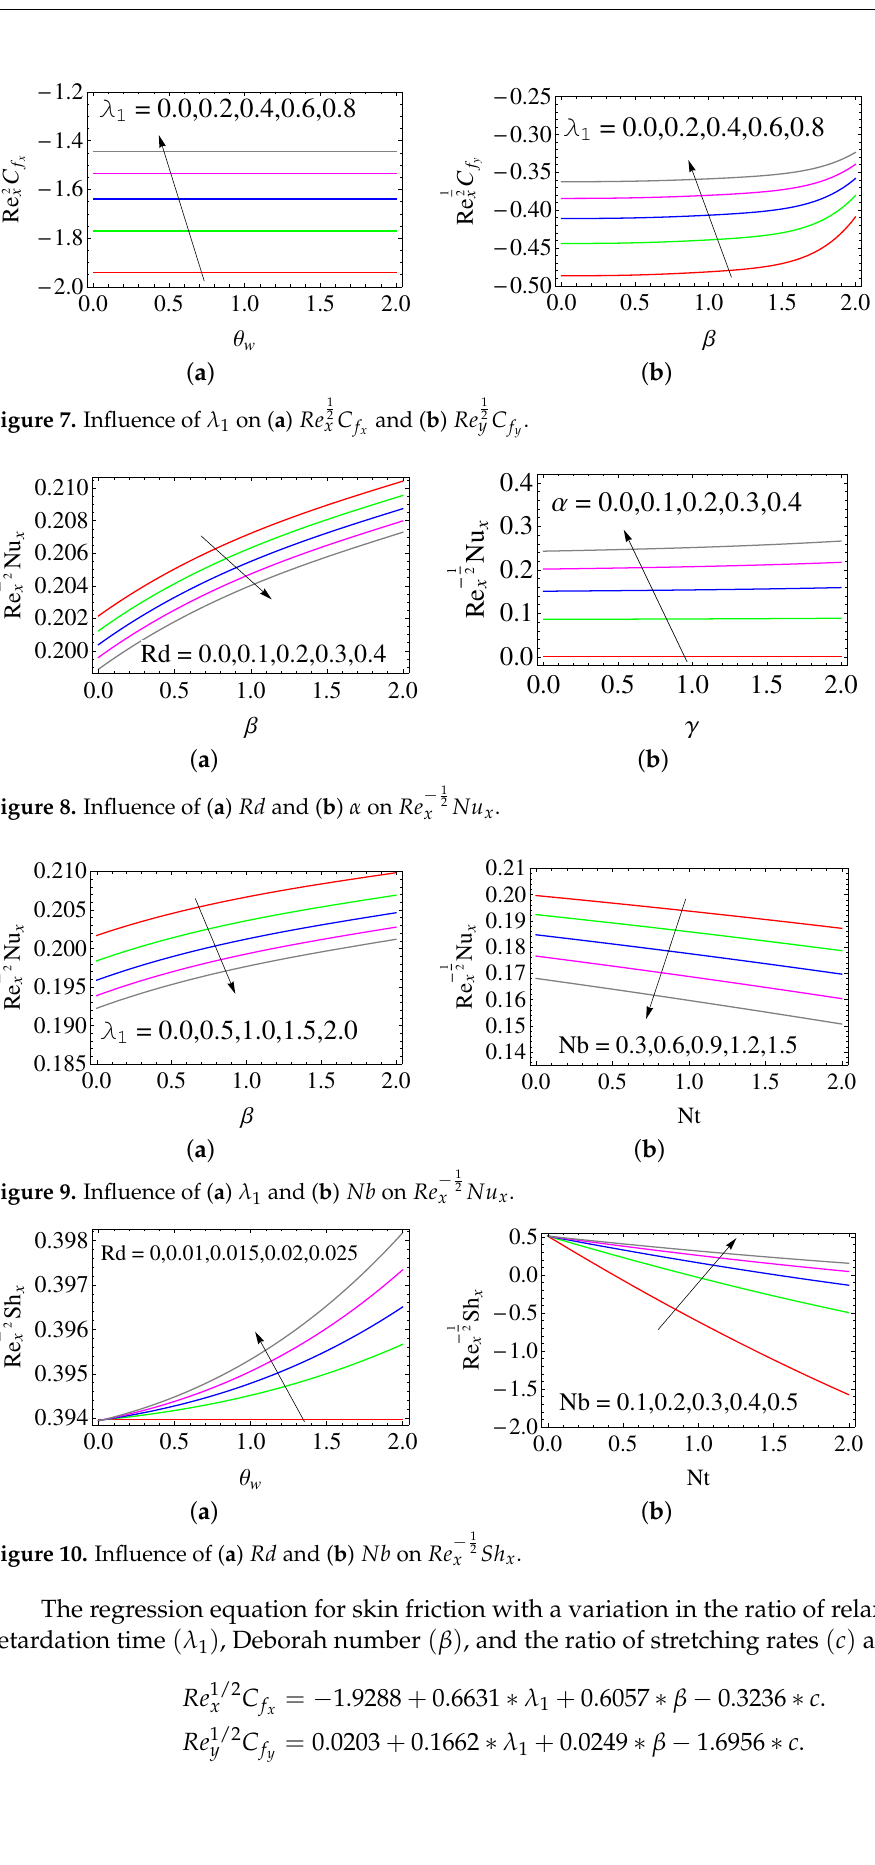
The regression equation for skin friction with a variation in the ratio of relaxation to retardation time ( λ 1 ) , Deborah number ( β ) , and the ratio of stretching rates ( c )